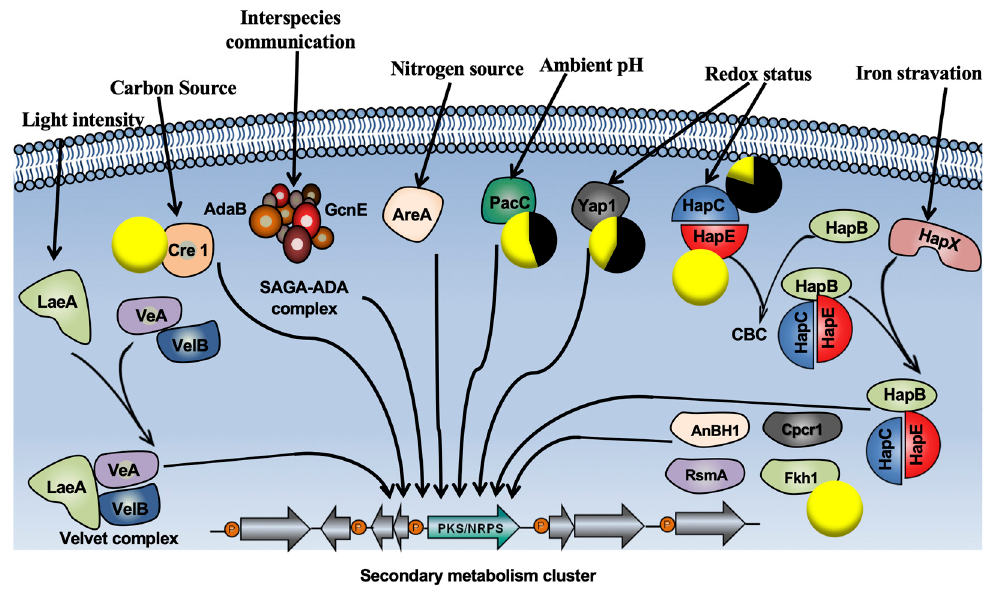
Figure 9. Regulatory proteins (RP) involved in the regulation of secondary metabolism gene clusters in fungi [23]. Regulatory proteins are shown in colors. Arrows and bars refer to direct interactions. Pie charts correspond to the expression level of Phaeomoniella chlamydospora genes encoding these RP in P. chlamydospora treatment (black), and Pythium oligandrum + P. chlamydospora (yellow) treatments. Only regulatory RP genes detected in our data are shown. Expression level values are given as FPKM (fragments per kilobase per million mapped fragments). Abbreviations: CBC: CCAAT-binding complex; CpcR1: cephalosporin C regulator 1; LaeA: loss of aflR expression A; RsmA: restorer of